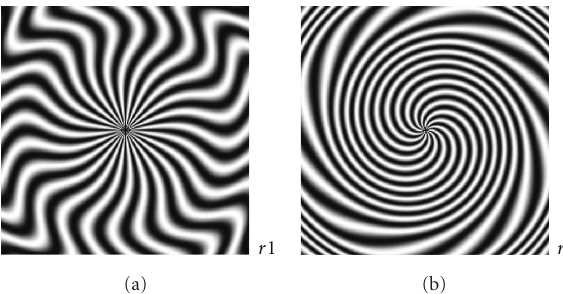
Figure 15: Interferogram when the test wave φ t 2 of Figure 13(d) interferes with (a) reference wave φ r 1 = mθ (b) reference wave φ r 2 = mθ + Cr